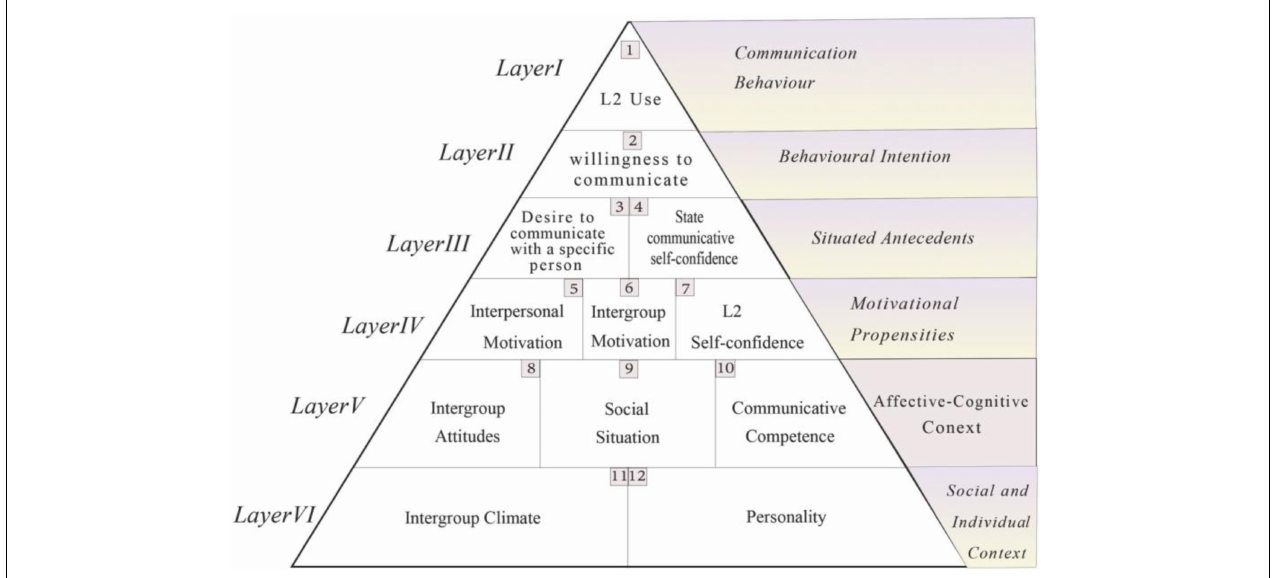
FIGURE 1 | The pyramid model, reproduced image adopted from MacIntyre et al. (1998, p. 547).